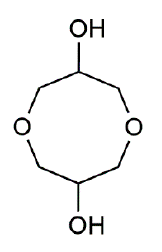
Figure 7. Influence of the catalyst type on the mass composition of the obtained oligoglycerols, de- termined on the basis of the ESI-MS spectra of the analyzed samples (m/z = [M − H] + ).